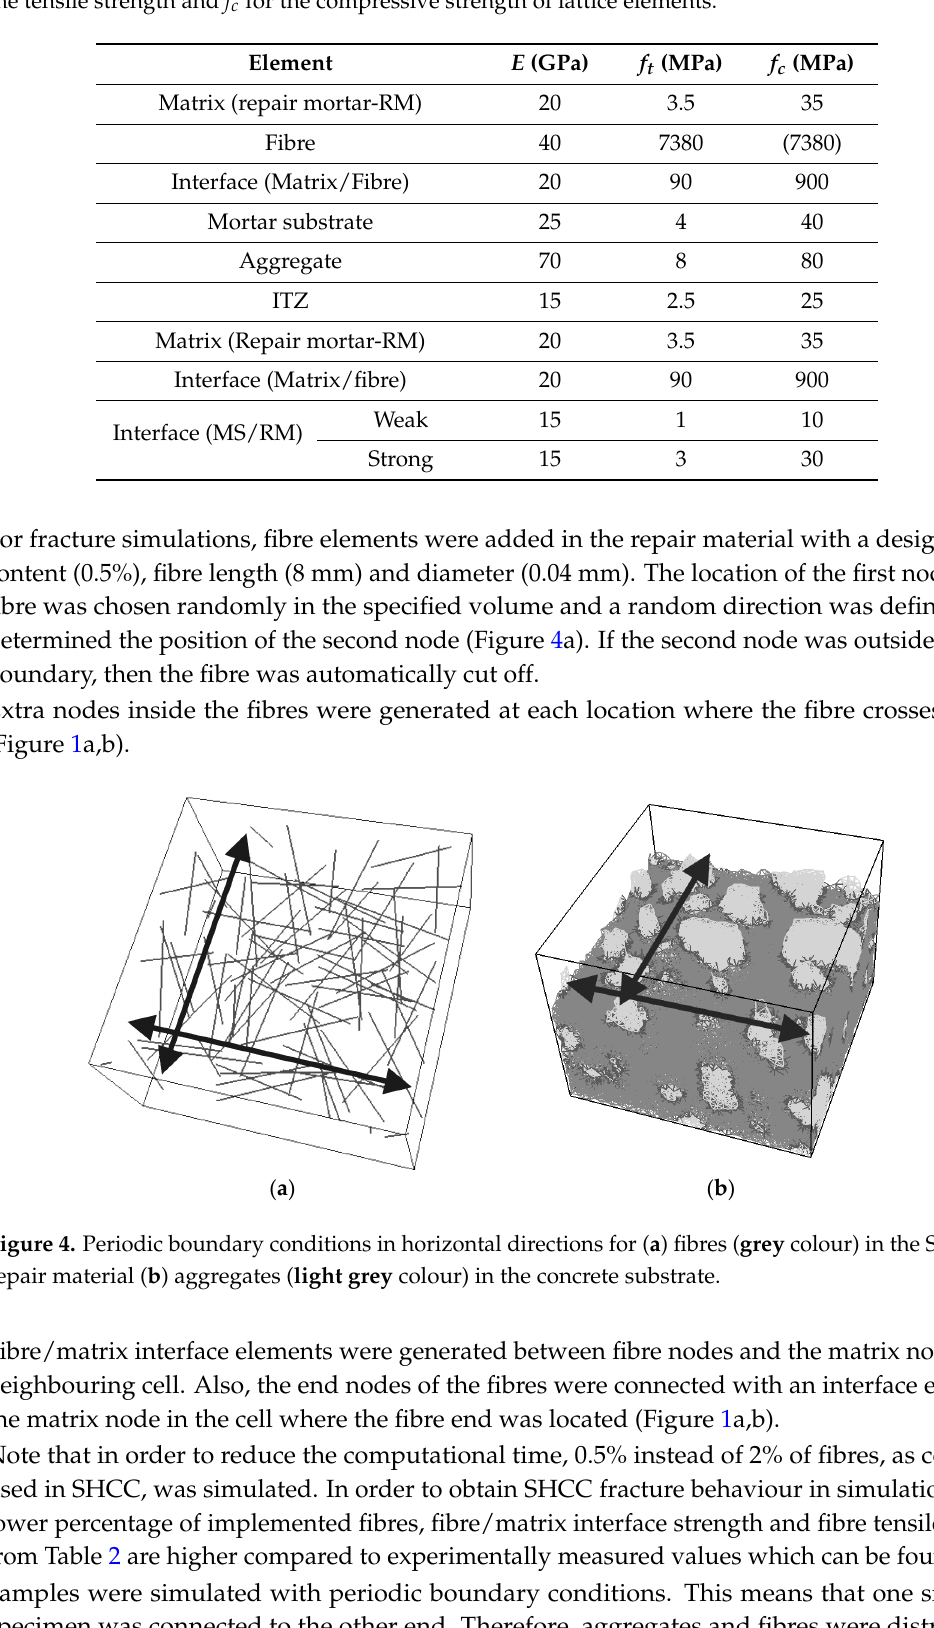
Table 2. Input values for lattice fracture model [27], E stands for the modulus of elasticity, f t stands for the tensile strength and f c for the compressive strength of lattice elements.